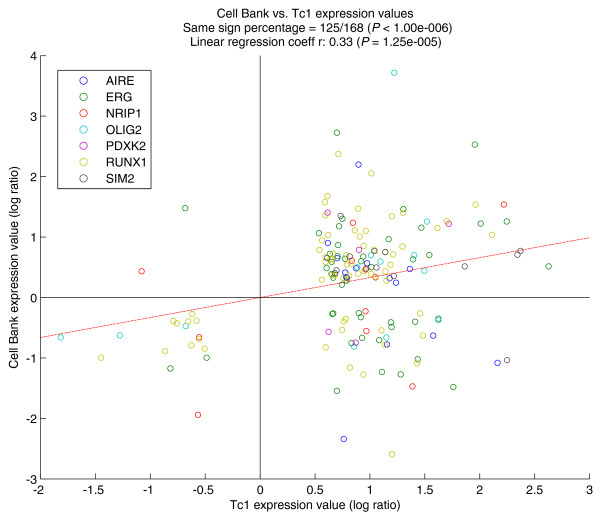
Comparison of differentially expressed genes following single gene over-expression in our cell bank mouse ES cell lines versus transchromosomic Tc1 mouse ES cell lines. The colors indicate the overexpression experiment in which the expression value was found to be significant; for genes whose expression was significant in more than one overexpression experiment, only the one with the largest absolute value was considered. A total of 168 points are in the graph, of which 125 fall in same-sign quadrants. The regression line was forced to pass through the origin in order to highlight the general trend with respect to zero.